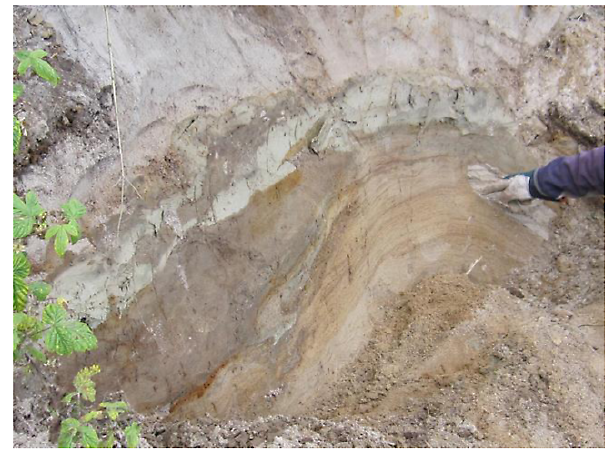
Fig. 6. Seismite? Disturbed water-filled sediment. Liquefaction. Photo by Soren